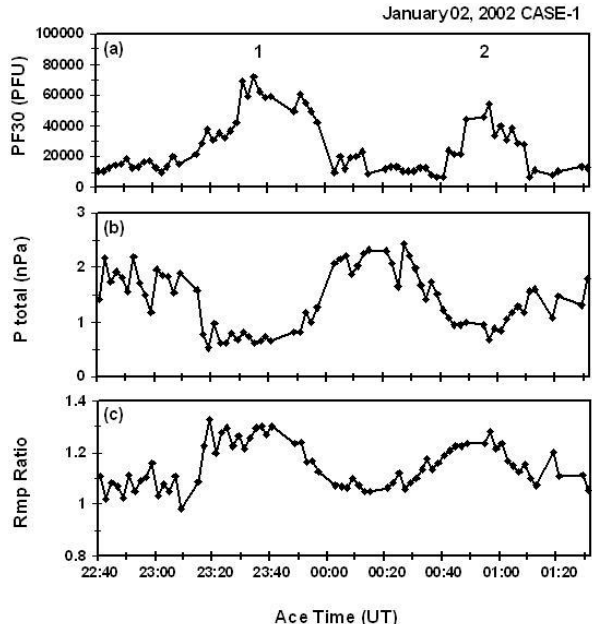
Fig. 17. Time variation of total pressure and the magnetopause ratio for Case 1 (2 January 2002). Panels from top to bottom give (a) par- ticle flux (PF30), (b) total pressure in the magnetosheath, and (c) the ratio of the magnetopause distances calculated using Cluster mag- netosheath and Ace solar wind observations. Shue’s magnetopause (1997) was used to calculate the magnetopause boundary. Time in- terval covers Bursts 1 and 2 in Case 1 and horizontal axis shows the time at